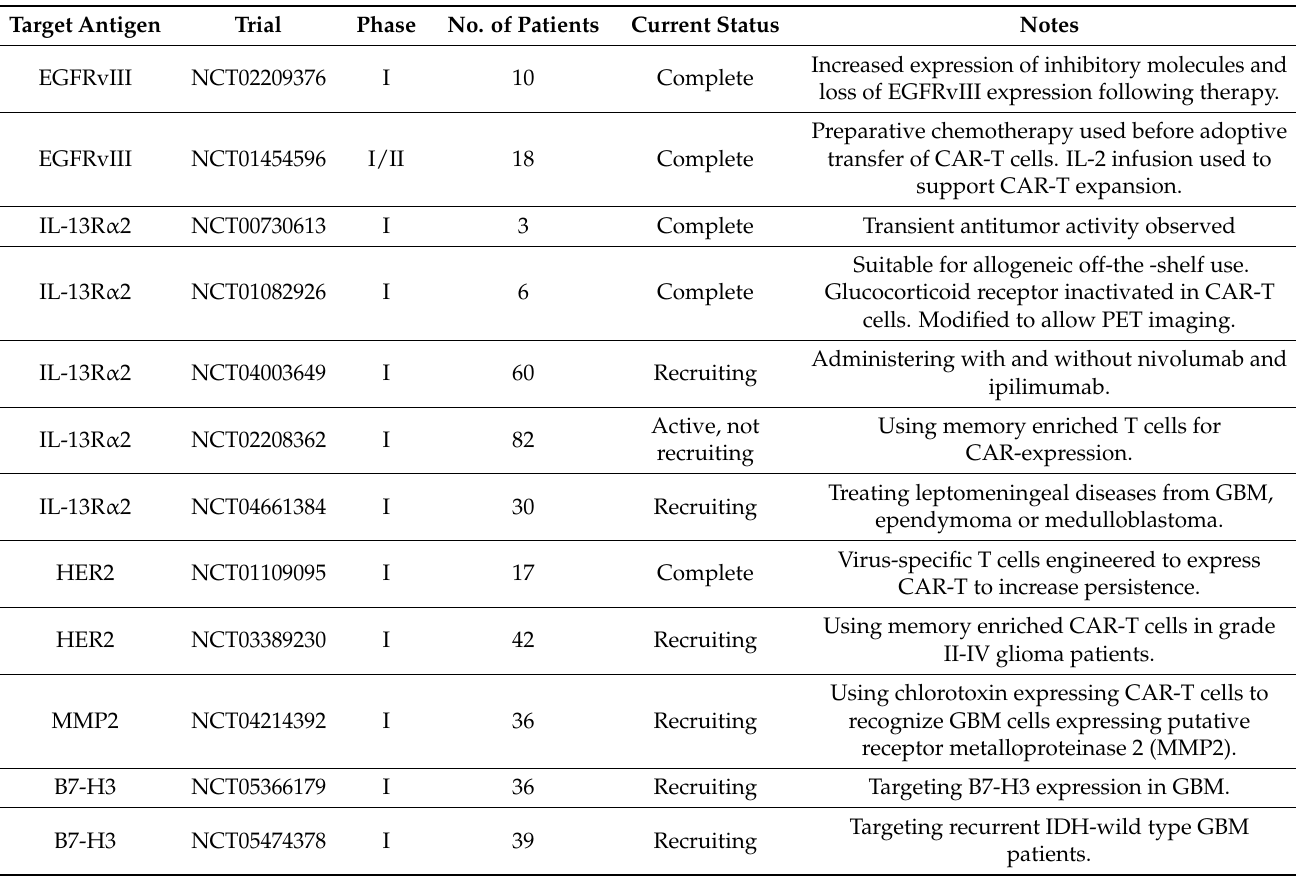
Table 1. Summary of clinical trials evaluating CAR-T cells in